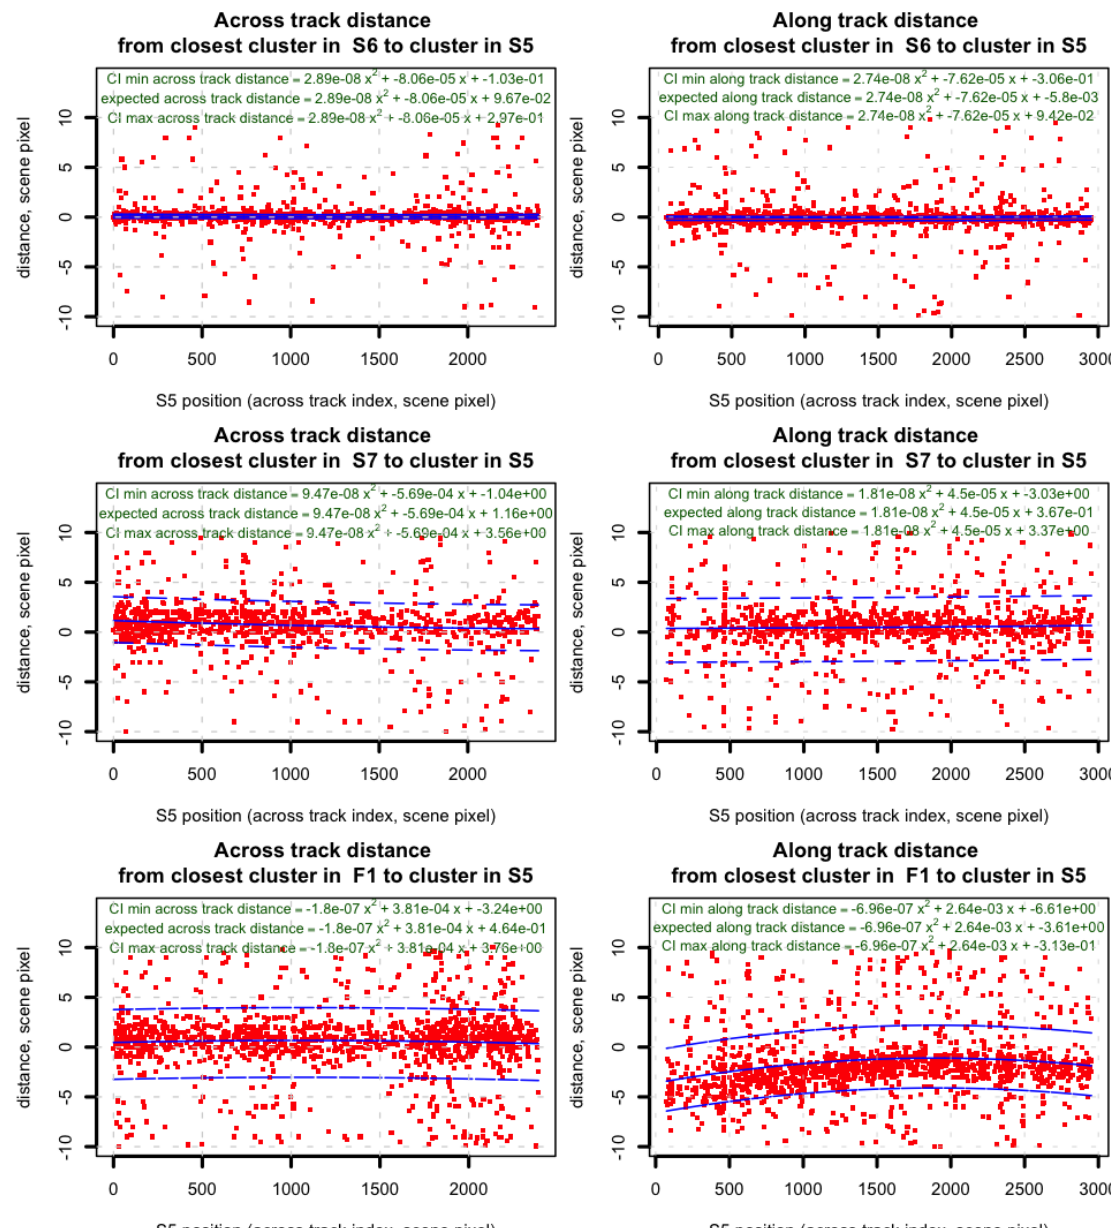
Figure 5. Parameterizations of the distances between a cluster in S5 and the closest cluster in S6, S7 and F1 as a function of the scan index. The solid line shows the best fit (second order polynomial). The dashed lines are parallel to the best fit so that 10% of the points are above resp. below. They represent the confidence